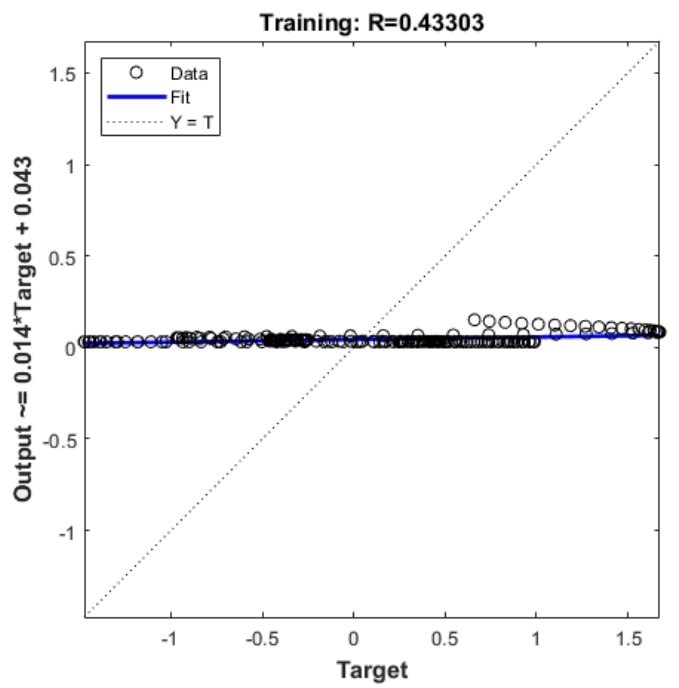
Figure 44. Neural network controller errors.